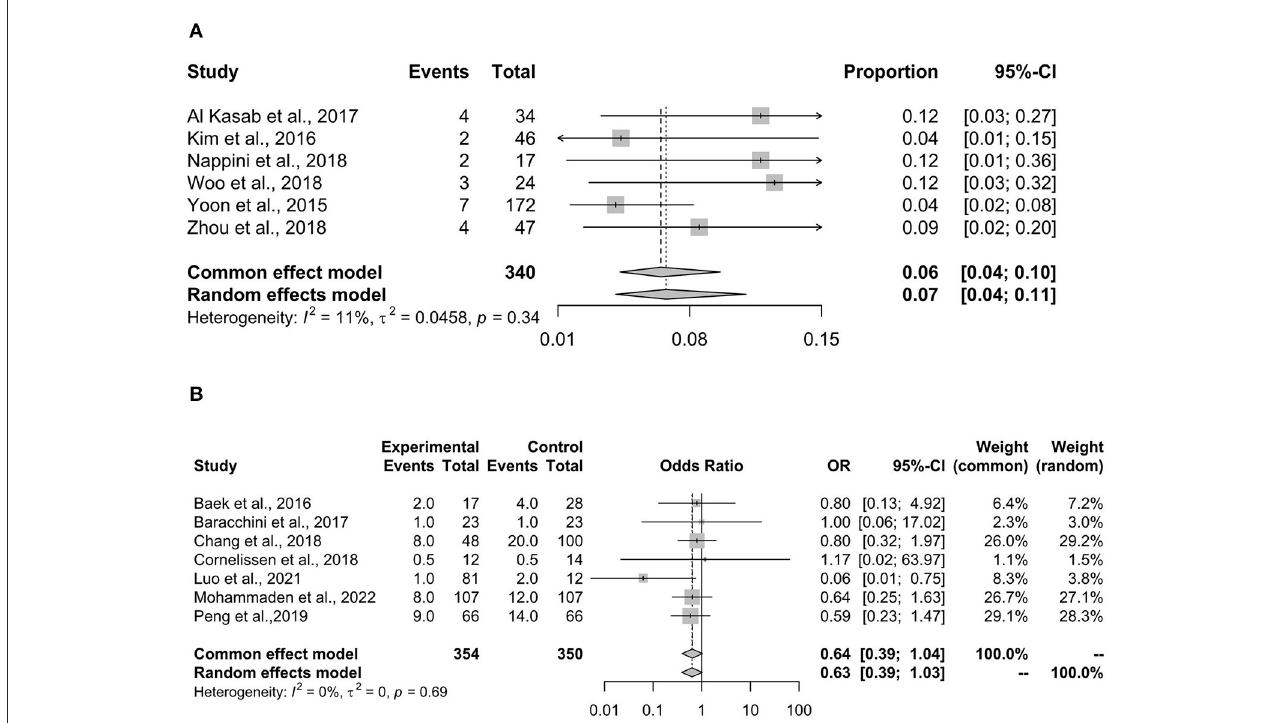
FIGURE3 The proportion of patients with sICH. sICH, symptomatic intracranial hemorrhage. sICH is a negative outcome for patients receiving rescue stenting. (A) Summarizes the proportion of patients developing sICH after receiving stenting. (B) Shows the comparison of stenting with non-stenting in the proportion of patients developing sICH, and a lower OR indicates a better result for the stenting arm. OR, odds